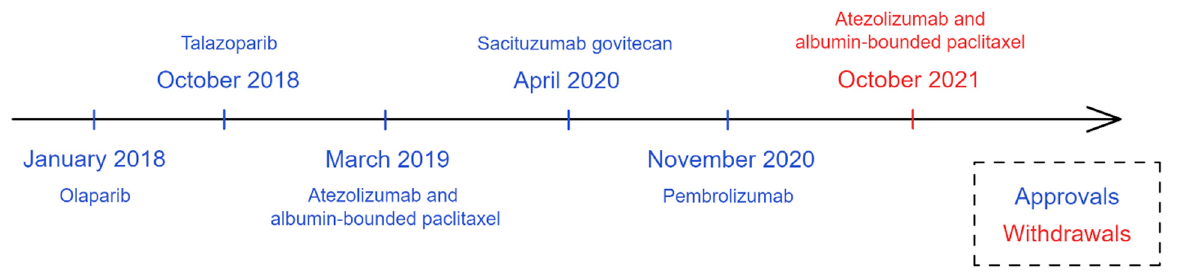
Figure 2. Timeline of US-FDA targeted therapy approvals and withdrawals for triple-negative breast cancer treatment. In blue, drugs approved and in red, drugs withdrawn.